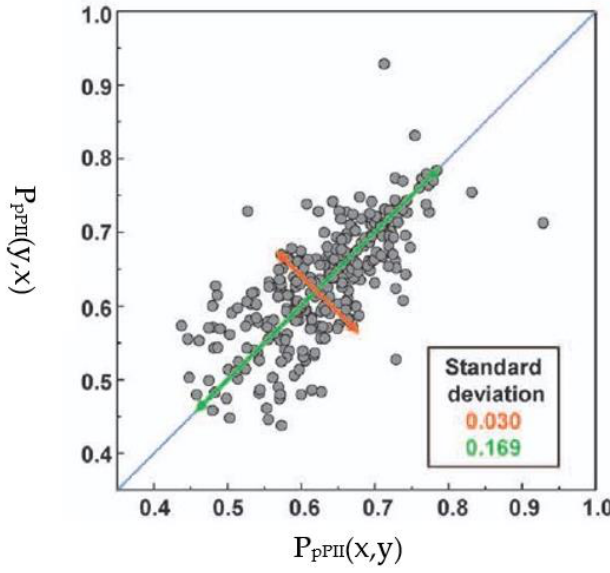
Figure 13. Correlation plot of the pPII propensities of amino acid residues in blocked tripeptides with the residue sequence xy versus the respective pPII propensities of the corresponding yx peptides. Proline residues were excluded. The figure was taken from [122] and modified.